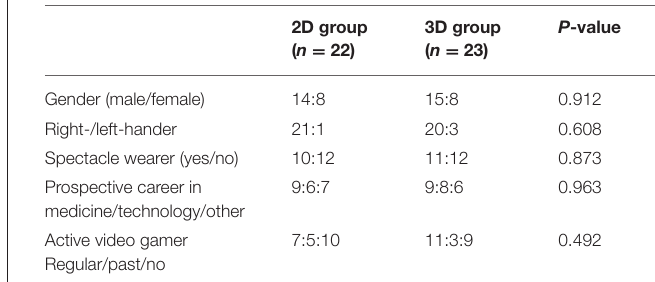
TABLE 1 | Background of the